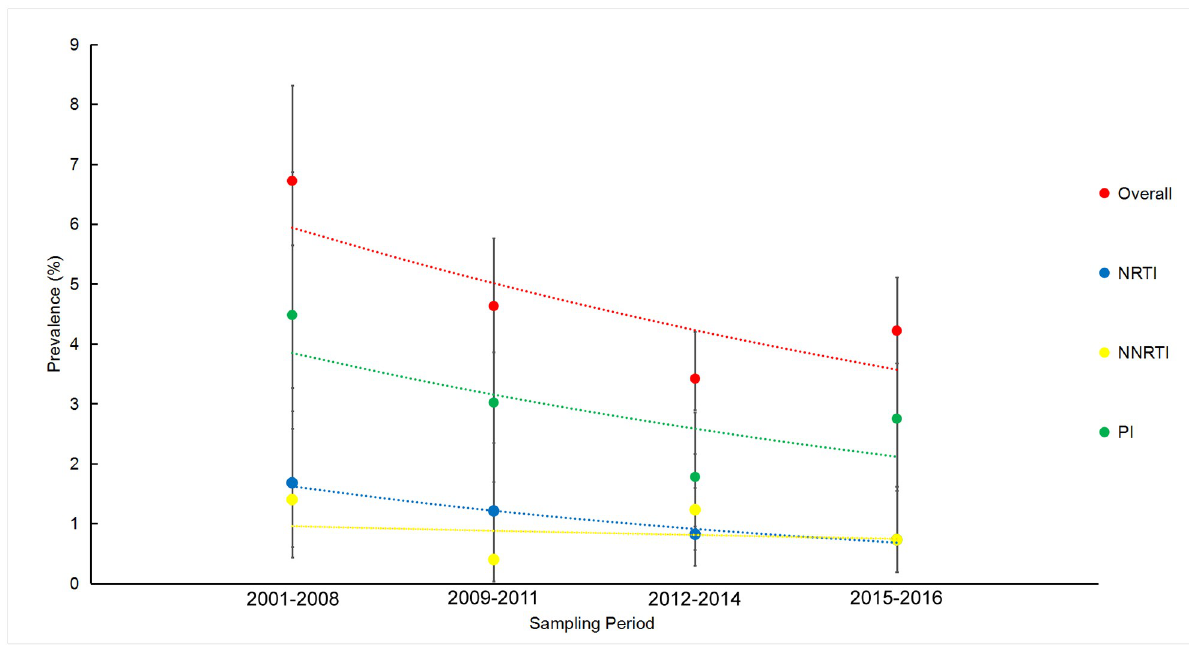
Fig 2. Temporal trends of prevalence of transmitted drug resistance by sampling phase. Vertical bars = 95% CI; The trend line is predicted prevalence of transmitted drug resistance; NRTIs = nucleoside reverse transcriptase inhibitors; NNRTIs = non-NRTIs; PIs = protease inhibitors.